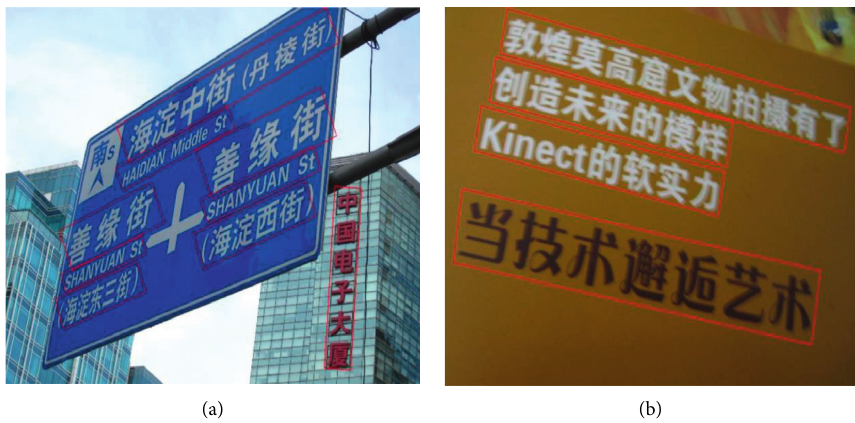
Figure 5: Recognition results of the AEMF algorithm from the CTW1500